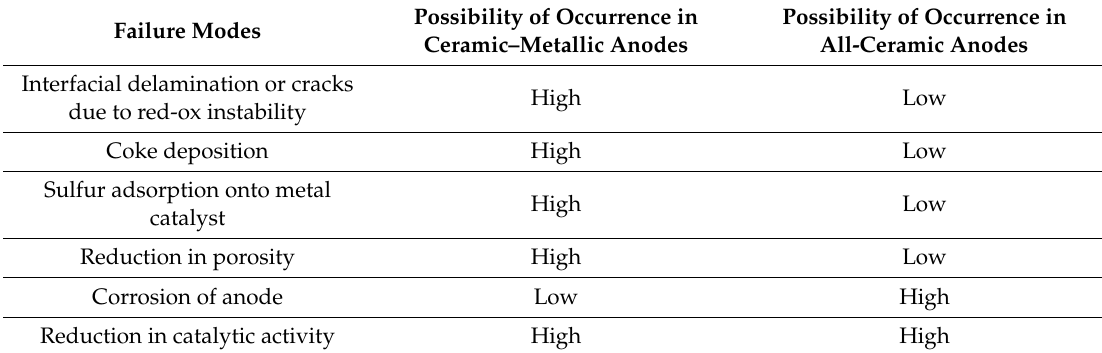
Table 2. Failure modes for ceramic–metallic anodes and all-ceramic anodes [17,43–46].